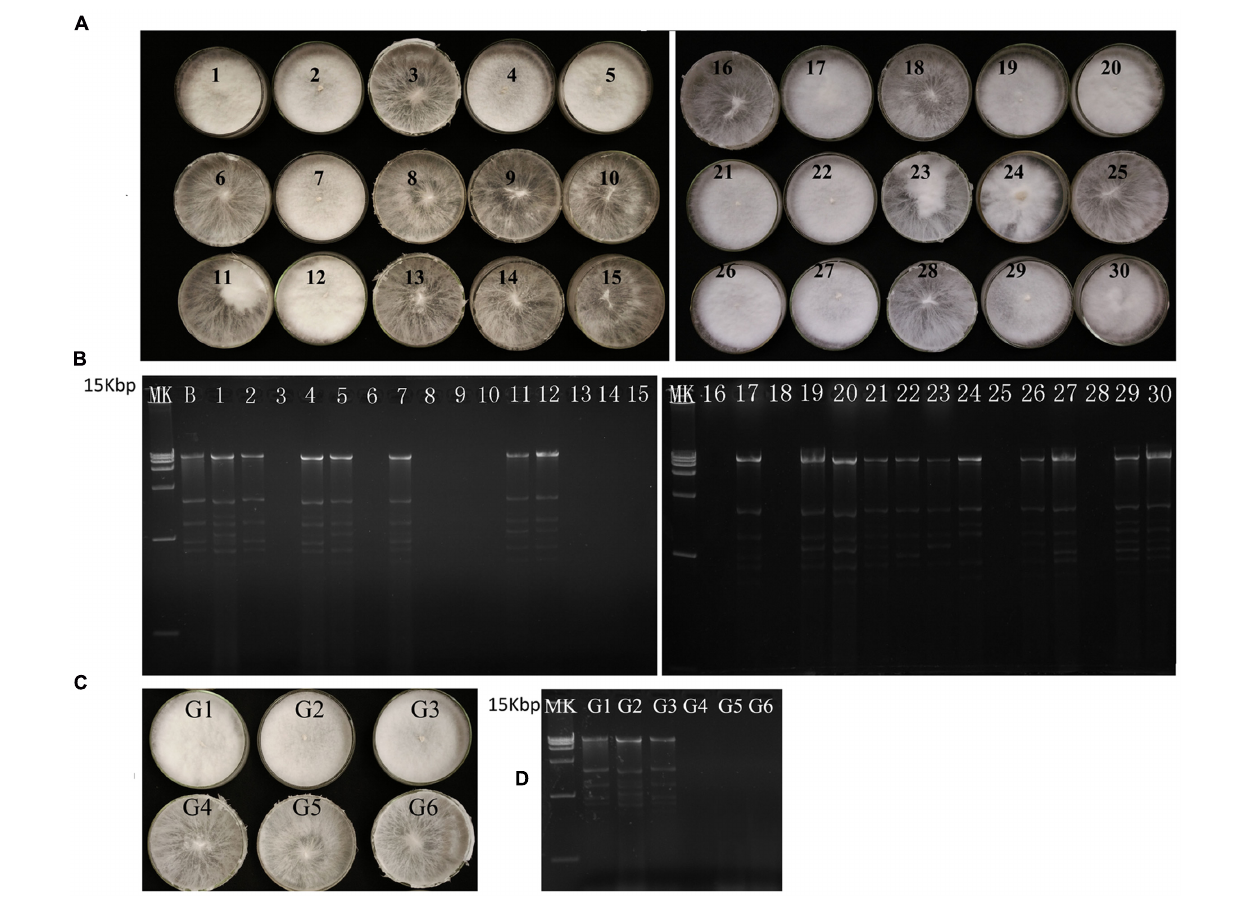
FIGURE 2 | Colony morphology and dsRNA detection results of the BLH-1 derivative isolates generated during virus curing. (A) Colony morphology of the BLH-1 derivative isolates obtained from protoplast regeneration. (B) dsRNA detection of these protoplast regenerating isolates. (C) Colony morphology of the BLH-1 derivative isolates obtained by hyphal tip isolation up to six consecutive generations represented by G1–G6. (D) dsRNA extraction from the G1 to G6 derivative isolates. No dsRNA can be extracted from the fourth generation of hyphal tip